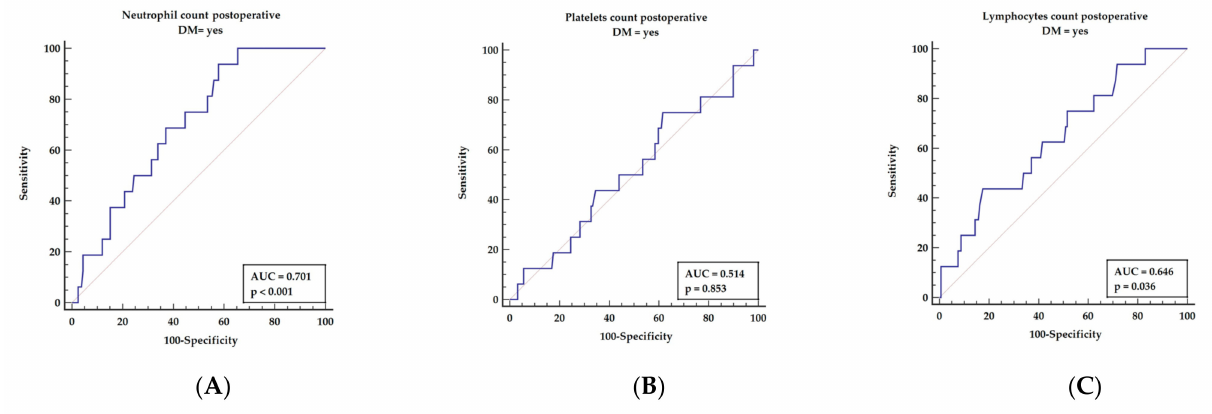
Figure 4. Postoperative simple components of SII index as predictive factors for long-term sur- vival in Cox analysis. Abbreviations: AUC—area under the curve, ( A ) neutrophils, ( B ) platelets, ( C ) lymphocytes. Lymp—lymphocytes count, Neu—neutrophil count, Plt—platelets